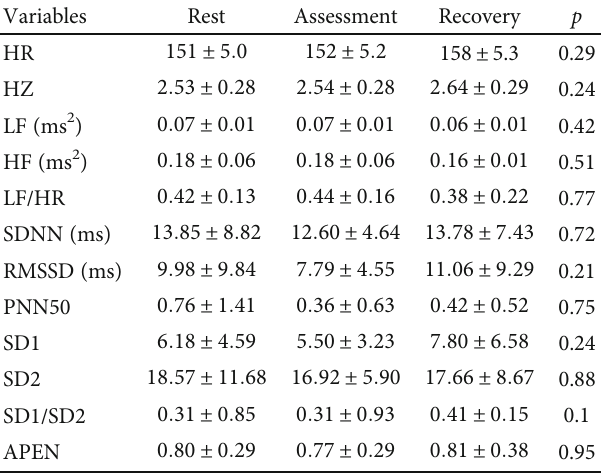
Table 5: Repeated measures